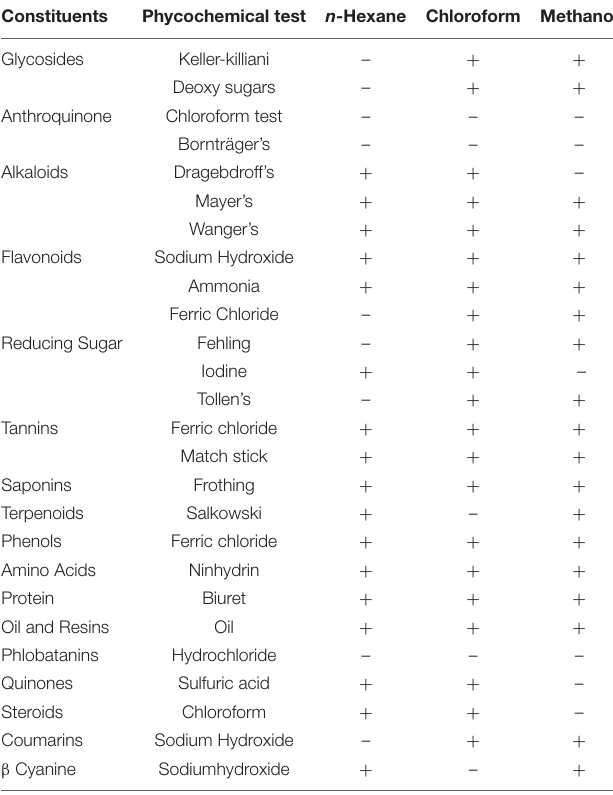
TABLE 1 | Qualitative analysis of Padina